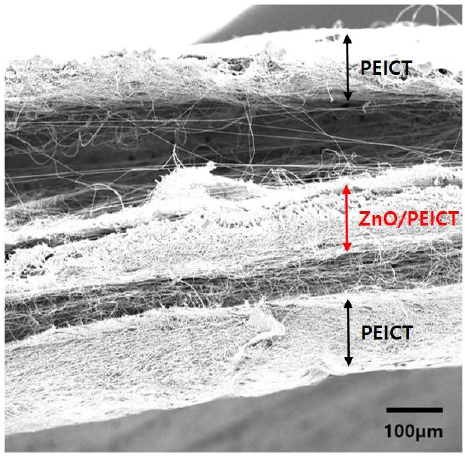
Figure 4. SEM image showing cross-sectional view of the tri-layered nanofiber mat structure prepared by sequential electrospinning.